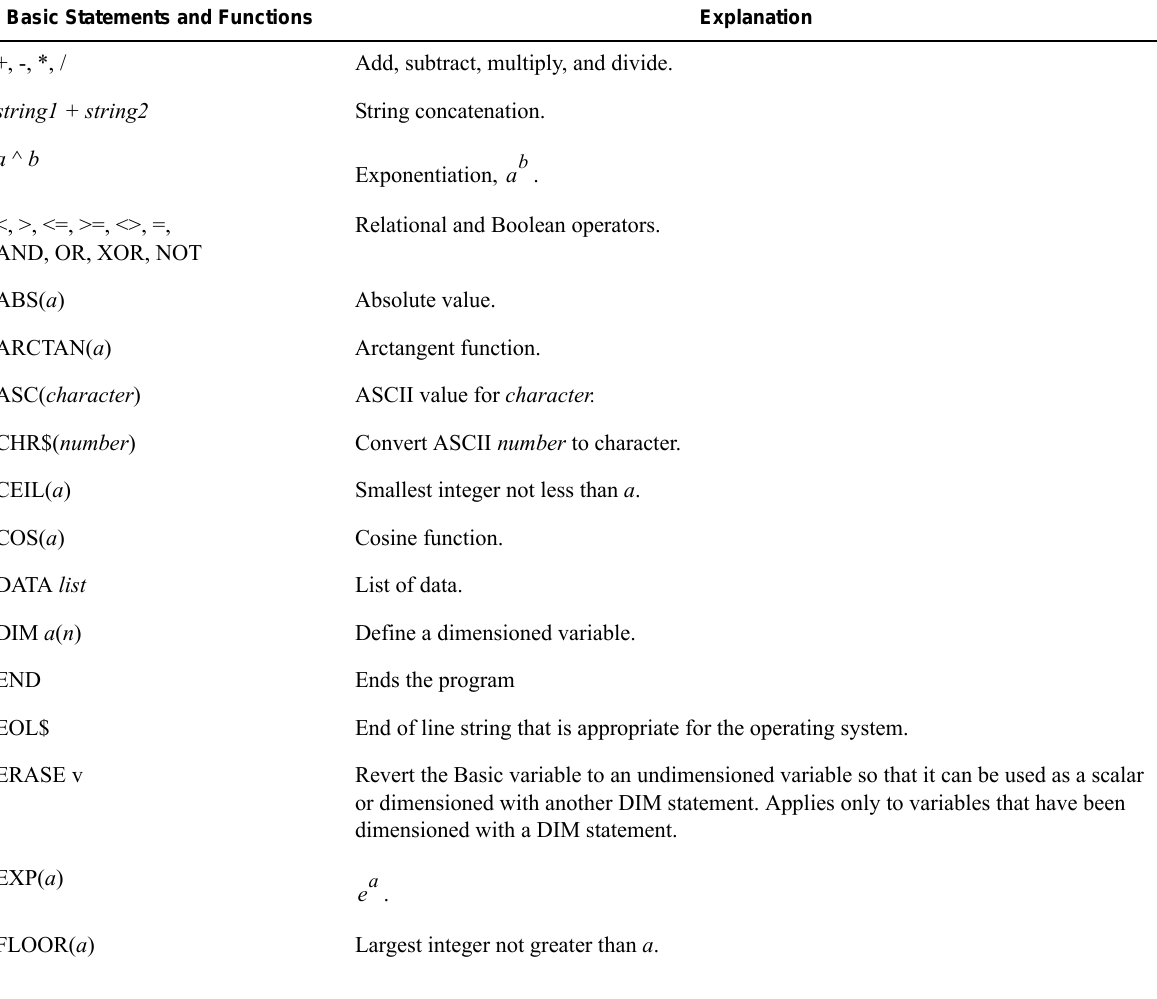
Table 7. Standard Basic statements and